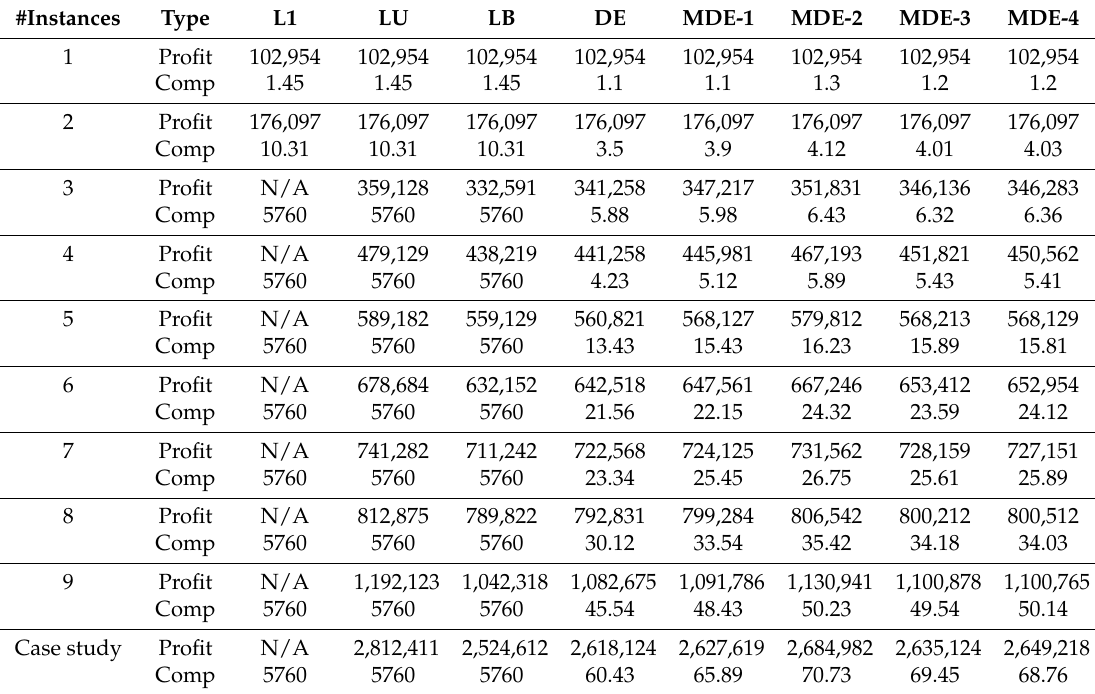
Table 13. Profit generated from different methods.